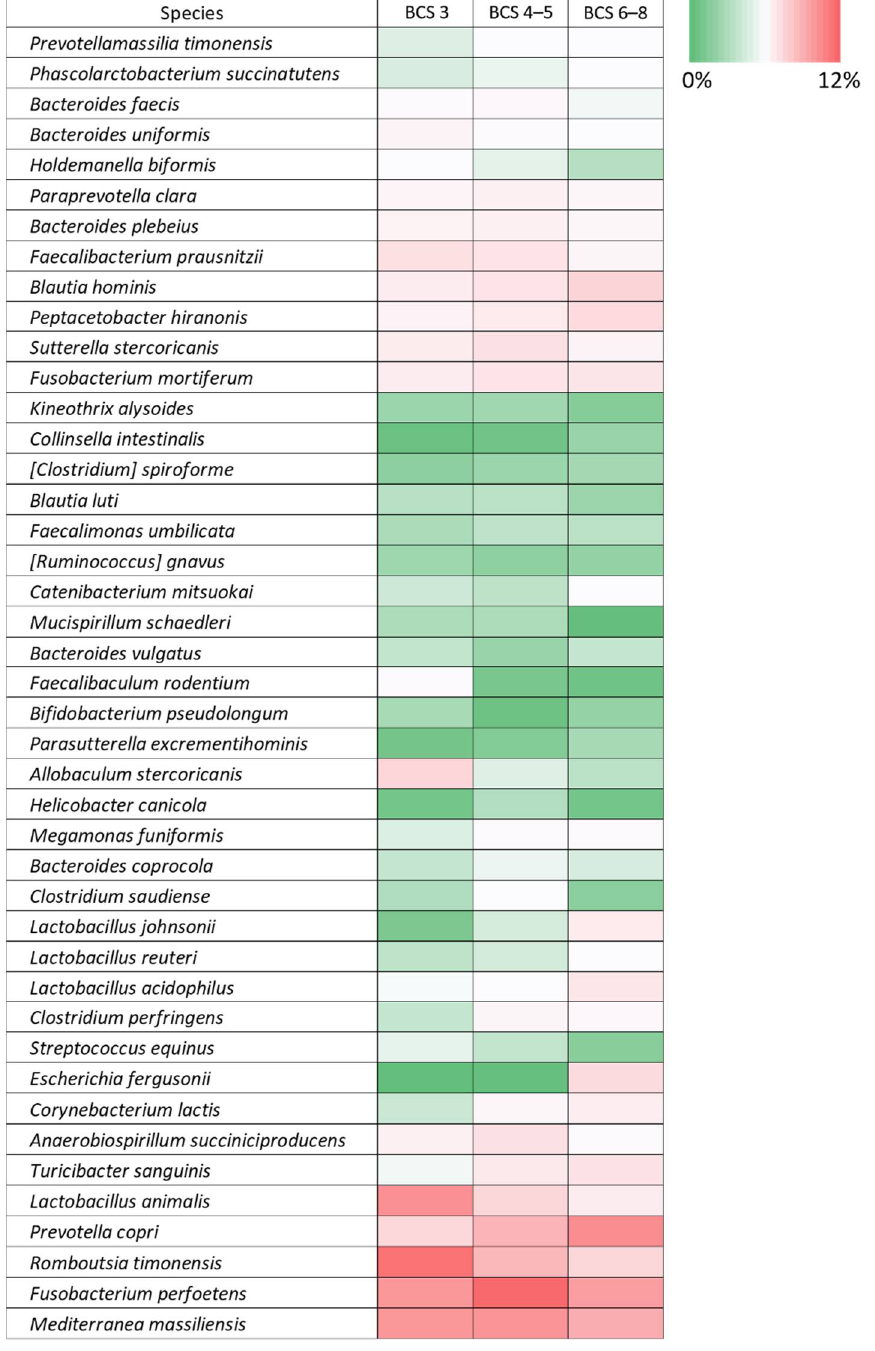
Figure 8. Heatmap of gut microbiota at the species level between different body condition score (BCS) groups. Color scale based on relative abundance of operational taxonomic unit (OTU). Forty-three core species were included in this analysis.